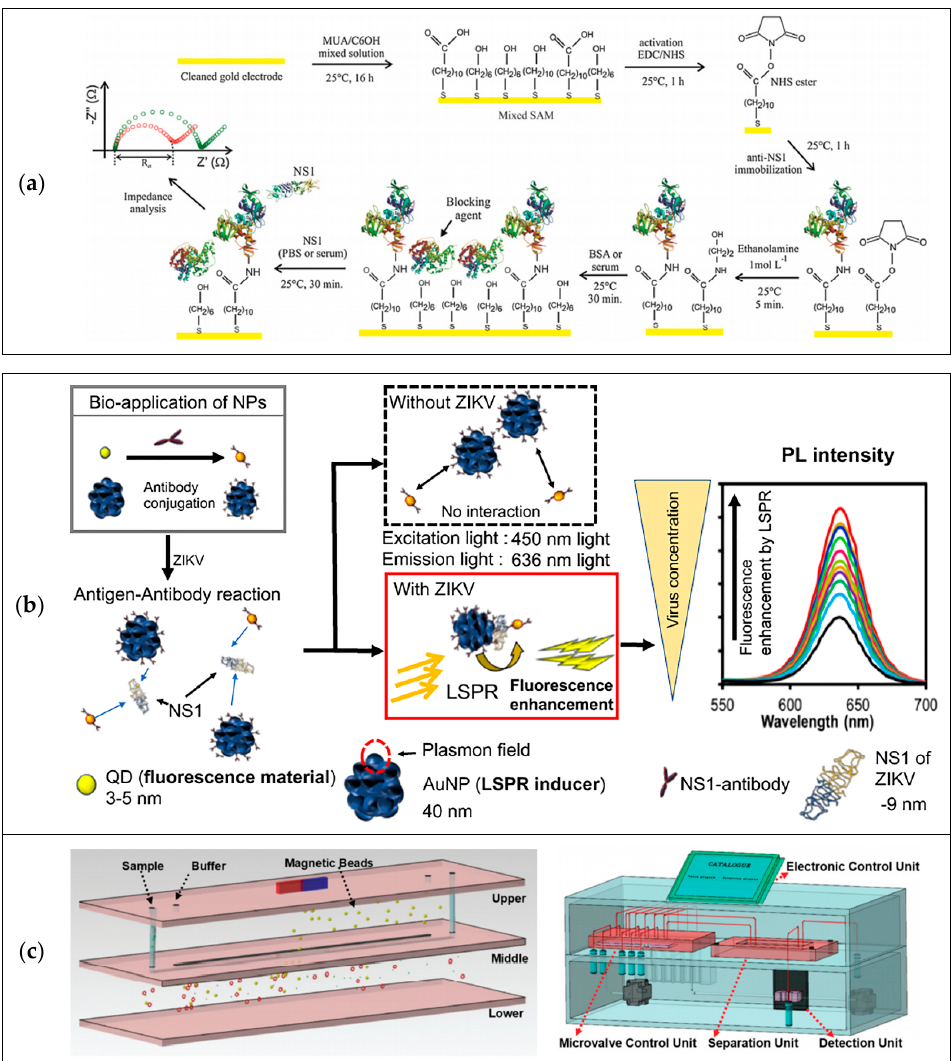
Figure 7. ( a ) Steps of electrode functionalization of the impedimetric biosensor to test neat serum for dengue diagnosis. The figure has been reproduced with permission from Elsevier [185]. ( b ) Schematic representation of the localized surface plasmon resonance (LSPR)-amplified immunofluorescence biosensor. The figure has been reproduced with permission from Takemura et al. [191]. ( c ) Schematic of the detection device based on the 3-D magnetophoretic separation and magnetic label. The figure has been reproduced with permission from the American Chemical Society [200].